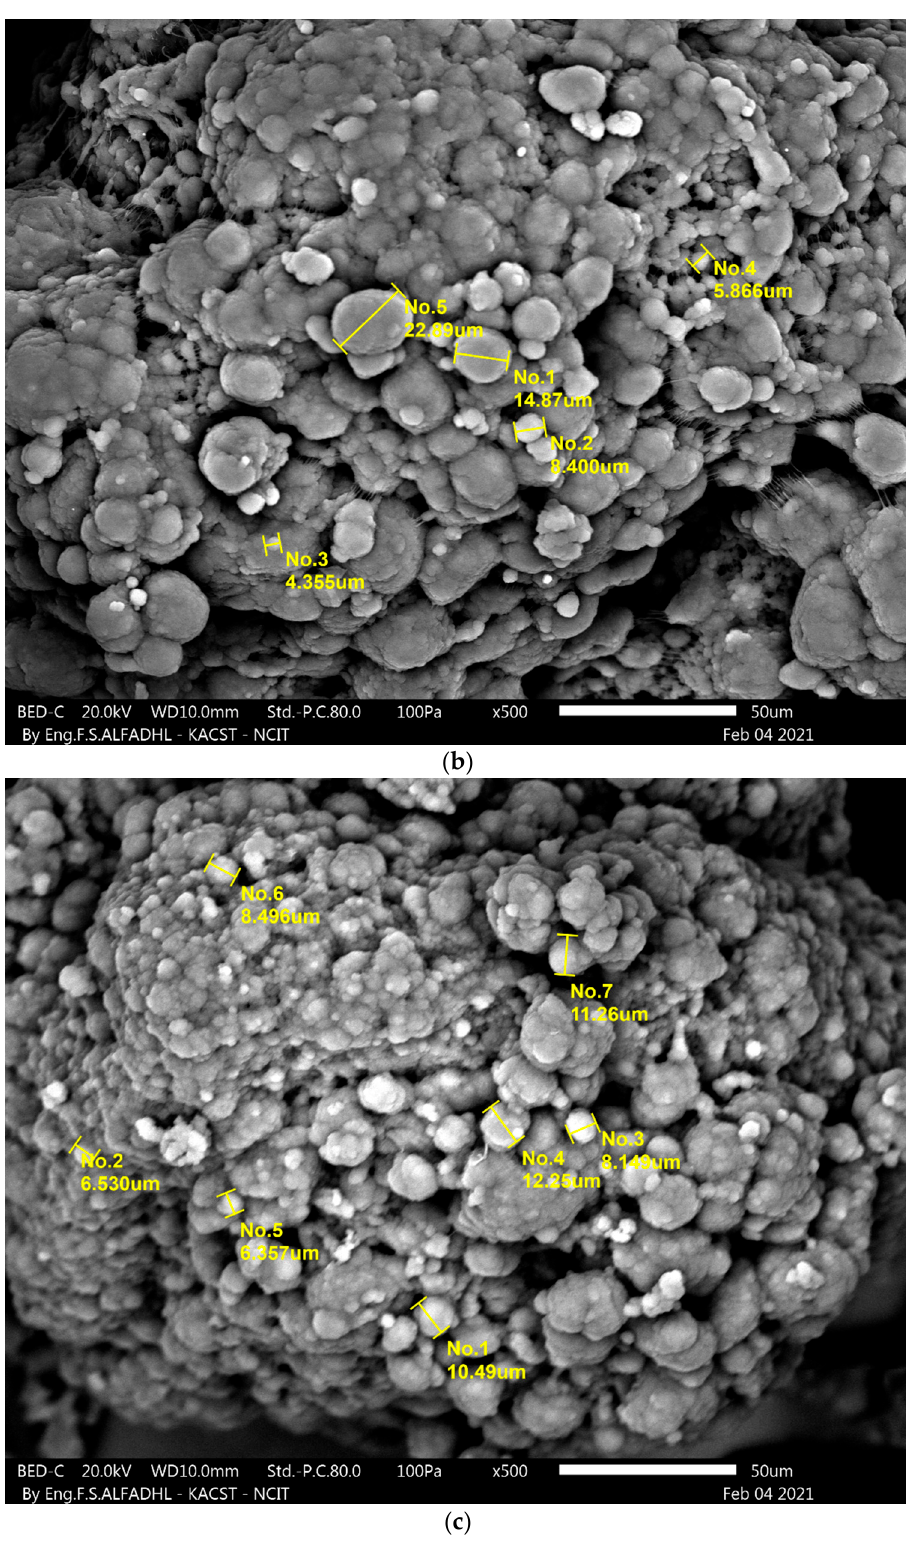
Figure 9. SEM images of the copolymer particles polymerized with catalyst using various 1-octene concentrations: ( a ) 32 mmol, ( b ) 64 mmol, and ( c ) 127 mmol. concentrations: ( a ) 32 mmol, ( b ) 64 mmol, and ( c ) 127